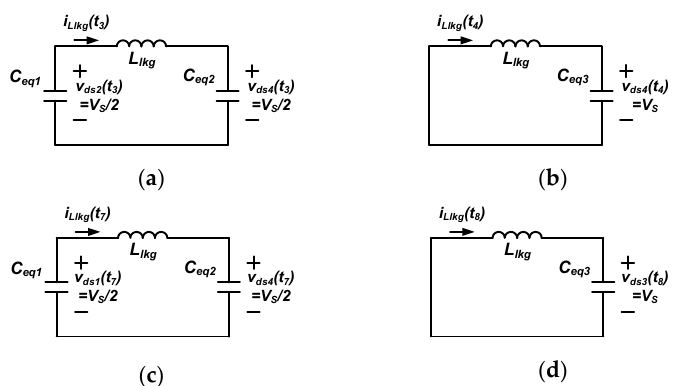
Figure 7. Equivalent circuit of the proposed converter during switching transitions. ( a ) Mode 3 ( t 2 – t 3 ). ( b ) Mode 4 ( t 3 – t 4 ). ( c ) Mode 8 ( t 7 – t 8 ). ( d ) Mode 9 ( t 8 – t 9 ).